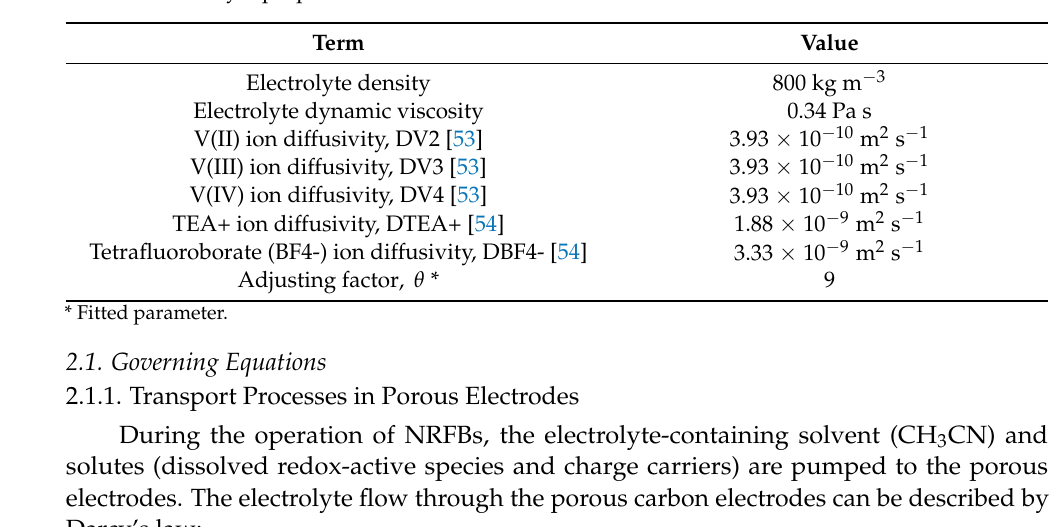
Figure 1. The computational domains of the present study. Table 1. Electrolyte